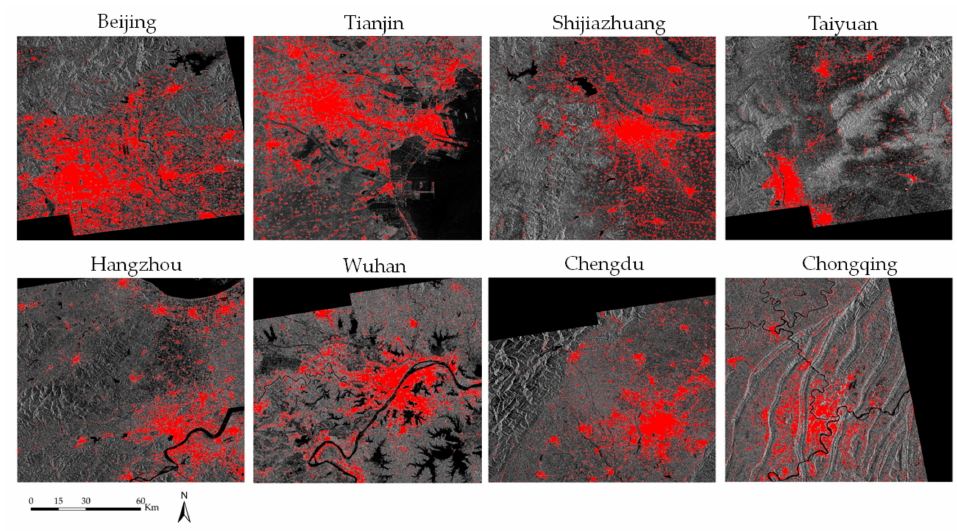
Figure 7. BAs extraction results overlaid on the SAR images of eight cities. Red: BAs.